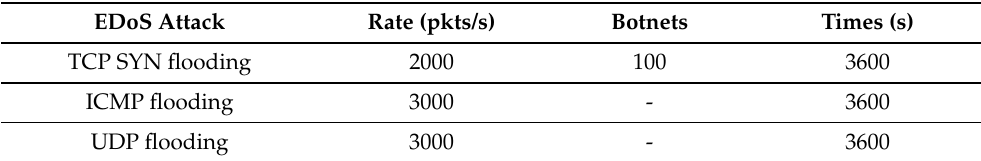
Table 1. EDoS attack by BoNeSi.